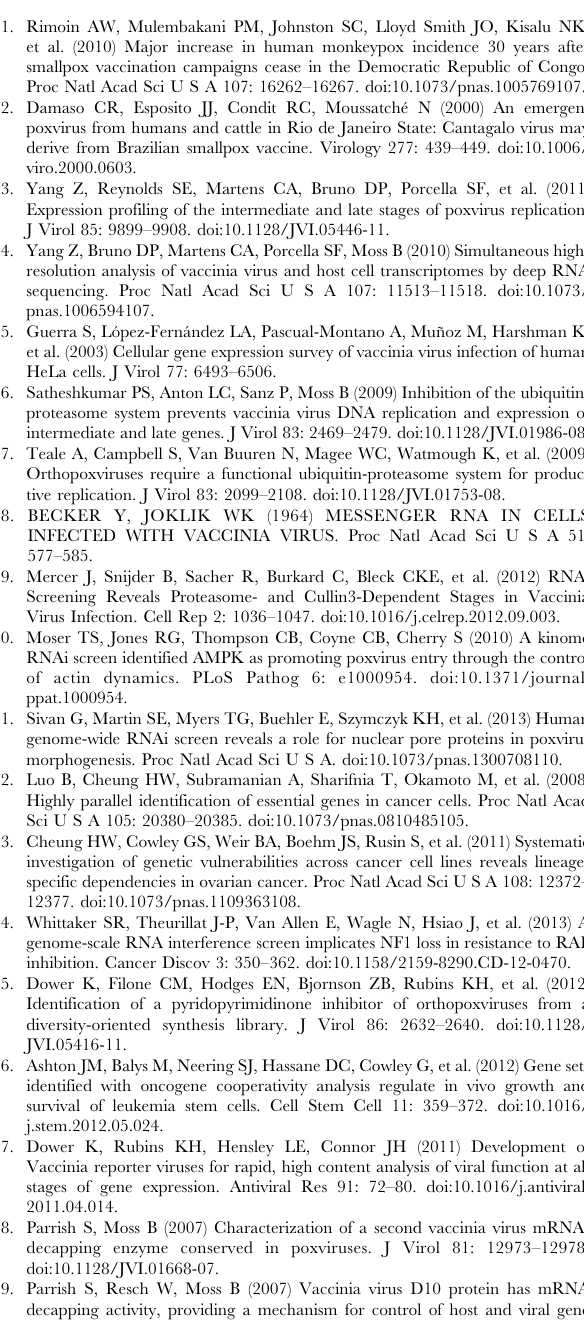
Table S7 Gene list of HSF1-regulated genes upregulated during VACV infection. Genes upregulated two-fold at 6 hpi in our dataset (top) or at 4 hpi in Yang et. al. WTA-A [4] (bottom).